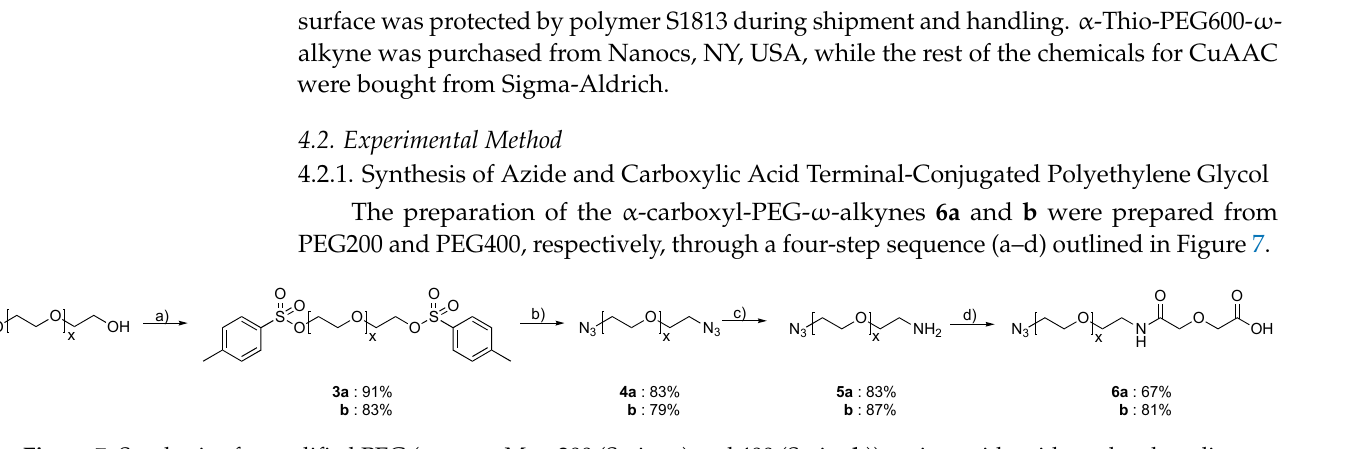
Figure 7. Synthesis of a modified PEG (average Mw: 200 (Series a ) and 400 (Series b )) moiety with azido and carboxylic acid terminals: ( a ). TsCl and. KOH in DCM at rt overnight; (b) NaN 3 in Et 2 O at 80 °C overnight; ( c ) PPh 3 in Et 2 O:1M HCl (1:1) rt overnight; ( d ) 2.0 eq. diglycolic anhydride and 0.2 eq. DMAP in DCM rt overnight. The chemical yield is given under each compound.